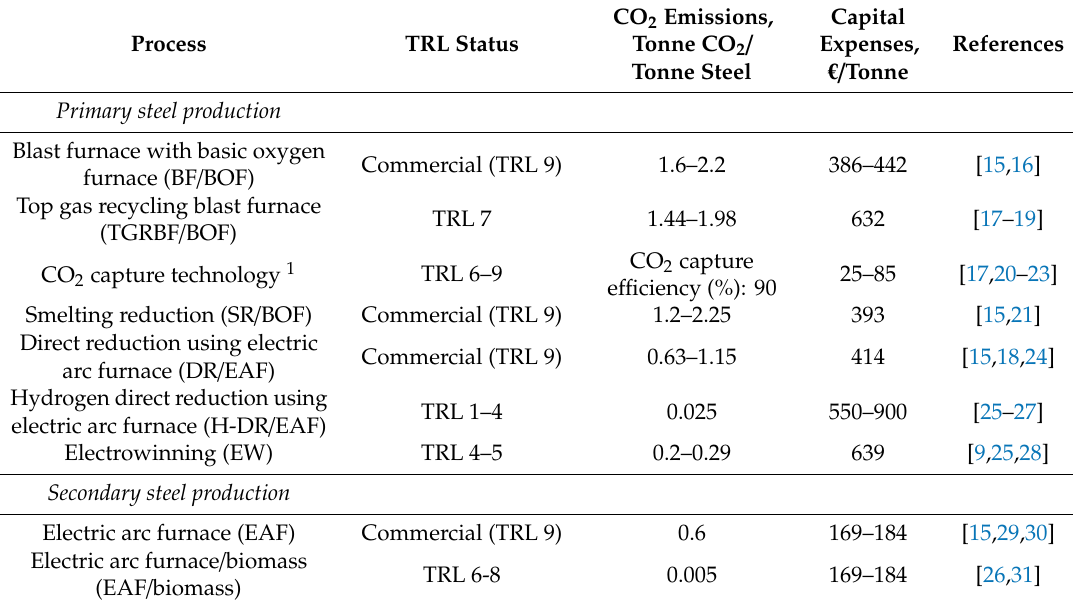
Table 1. Specifications of current commercially available and new transformative low CO 2 production processes for steel production in greenfield production